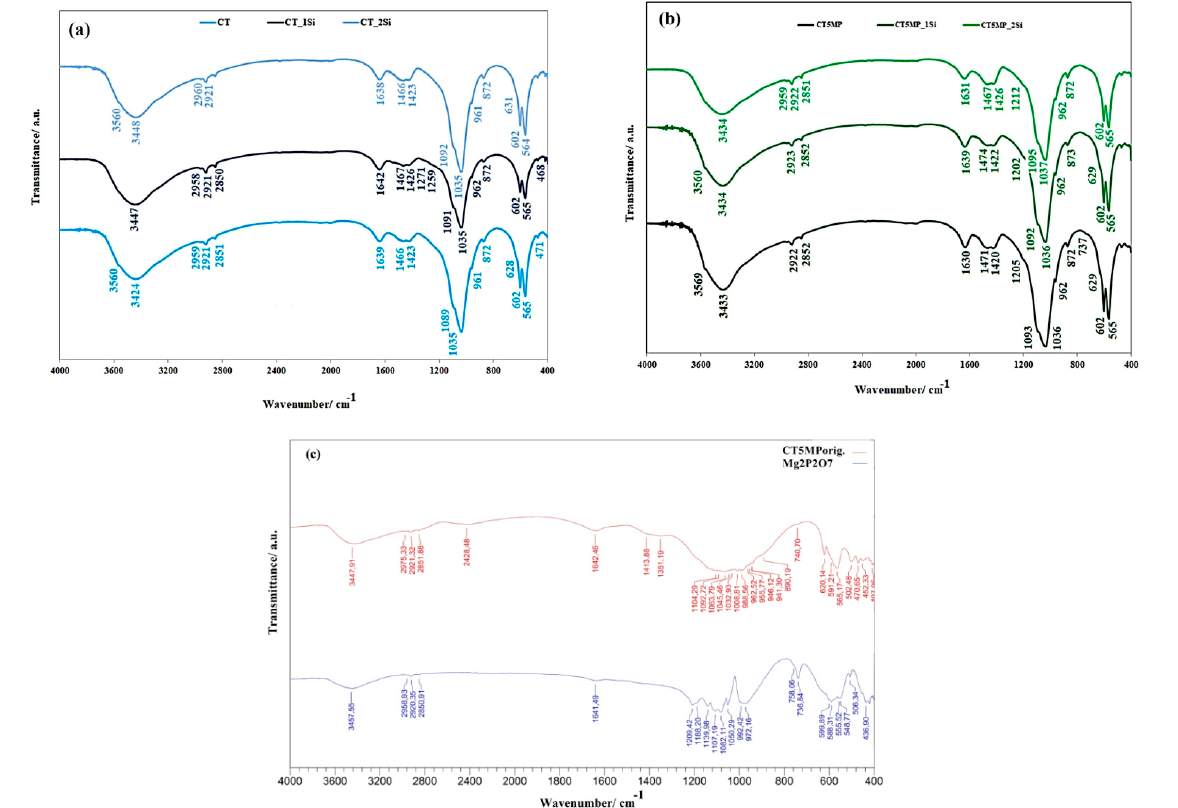
Figure 2. FTIR spectra of ( a ) CT powder mixture and CT1Si, CT2Si cements after 7 days soaking in SBF; ( b ) CT5MP powder mixture and CTMP1Si, CTMP2Si cements after 7 days soaking in SBF; ( c ) CT5MP origin powder mixture before soaking in SBF and Mg 2 P 2 O 7 .